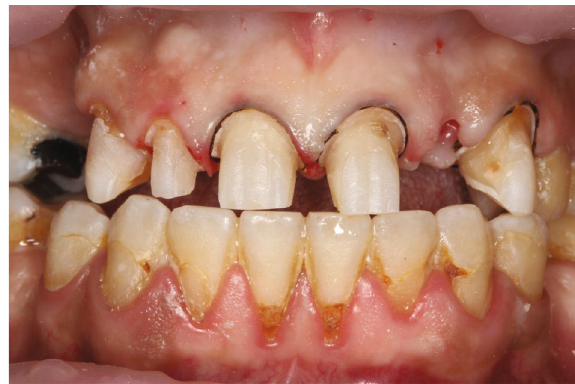
Figure 3: The extraction site with the maxillary anterior teeth after preparation at the follow-up appointment two weeks after extraction.